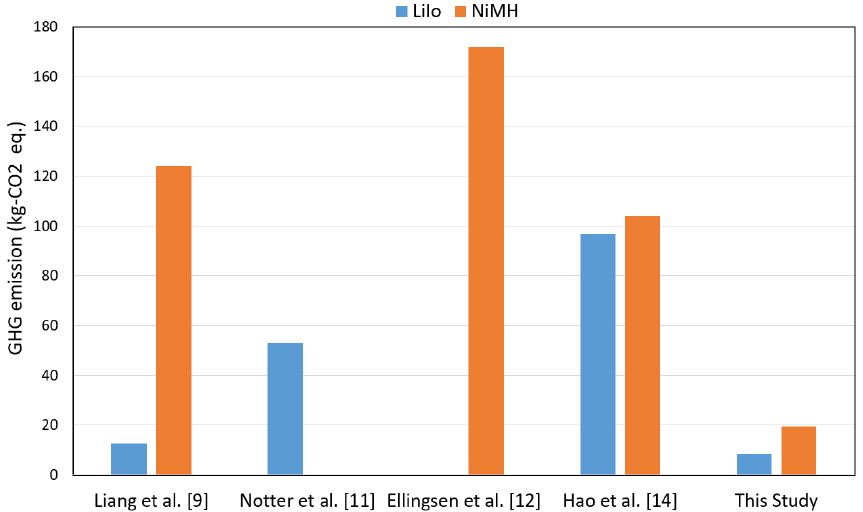
Figure 13. Comparison of the GHG emission outcomes of LiIo and NiMH batteries with existing